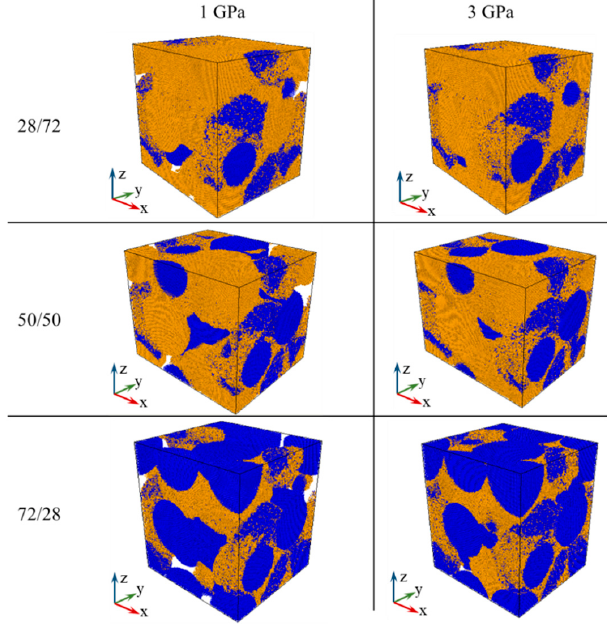
Figure 4. The structure of obtained 28/72, 50/50, and 72/28 Fe (blue)–Cu (orange) samples consolidated at 1 GPa (left column) and 3 GPa (right column). Large unfilled cavities (white) are observed in the samples consolidated at 1 GPa and in the sample with large (72 at.%) content of iron consolidated at 3 GPa (the leftmost sample at the bottom).